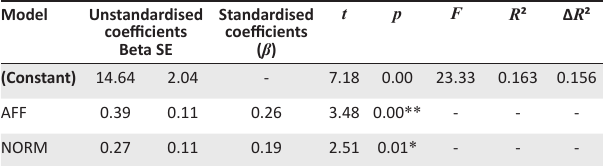
TABLE 5: Multiple regression with absorption (work engagement) being the dependent variable and normative and affective commitments (organisational commitment) the dependent